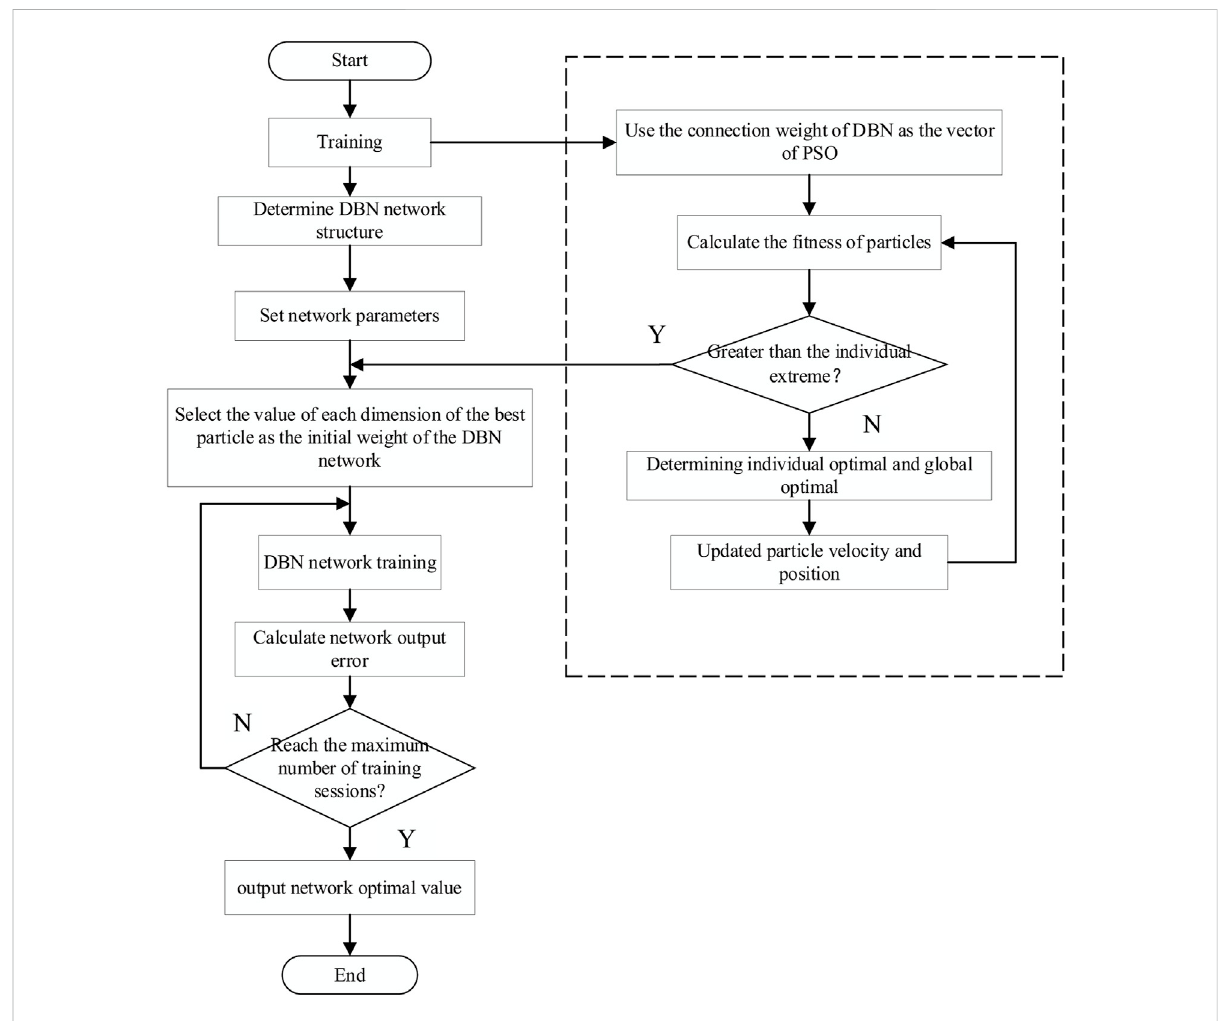
FIGURE 6 Flow chart of PSO – DBN network